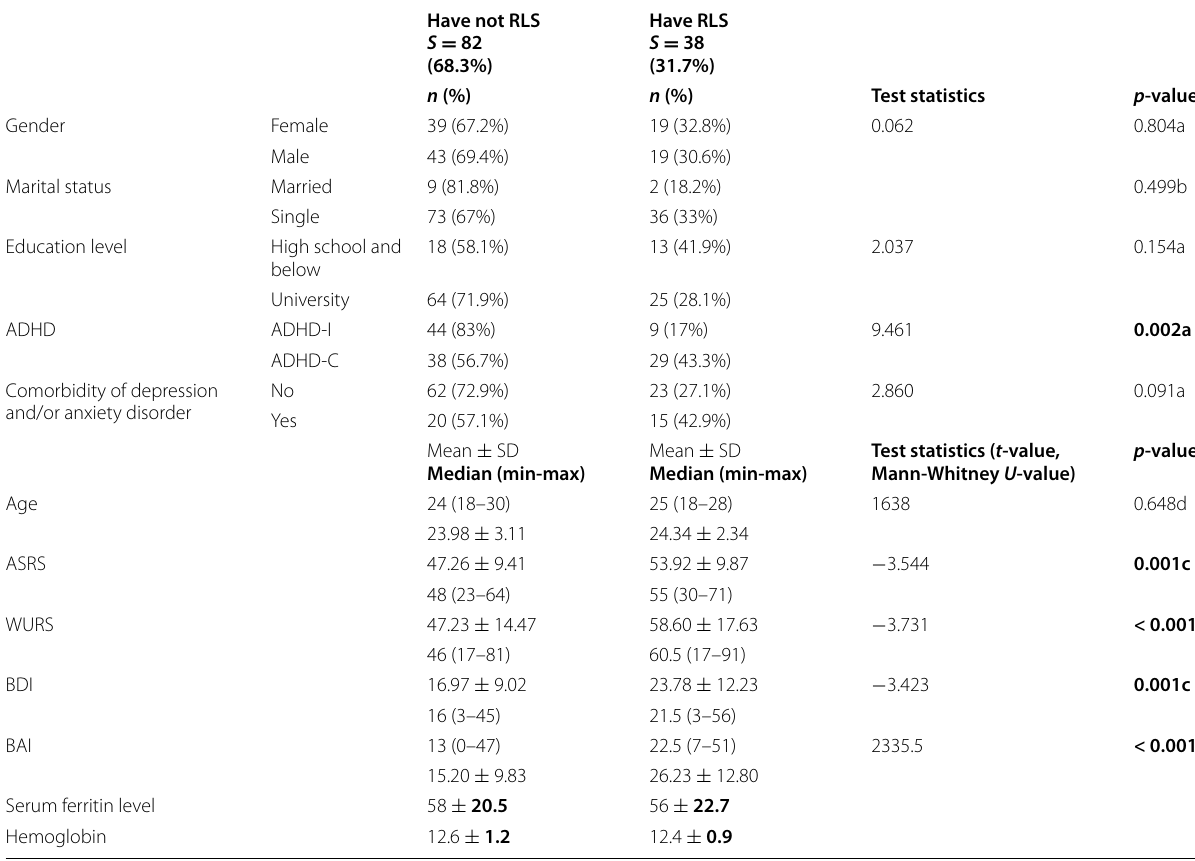
Table 2 Comparison of demographic characteristics, ADHD, depression and/or anxiety disorder comorbidity, ASRS, WURS, BDI, and BAI scale scores between RLS groups